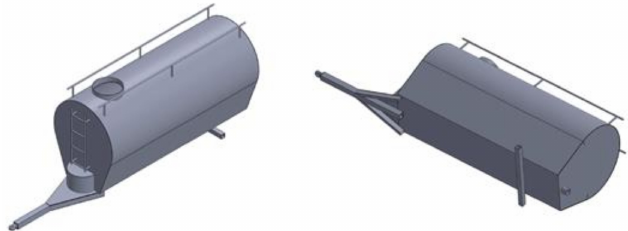
Figure 10. Different views of the agricultural water bowser